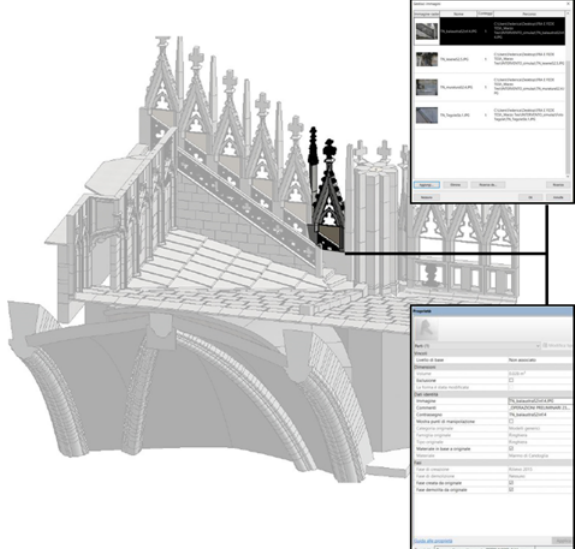
Figure 11. Final parametric model with Revit 16, with the information inside